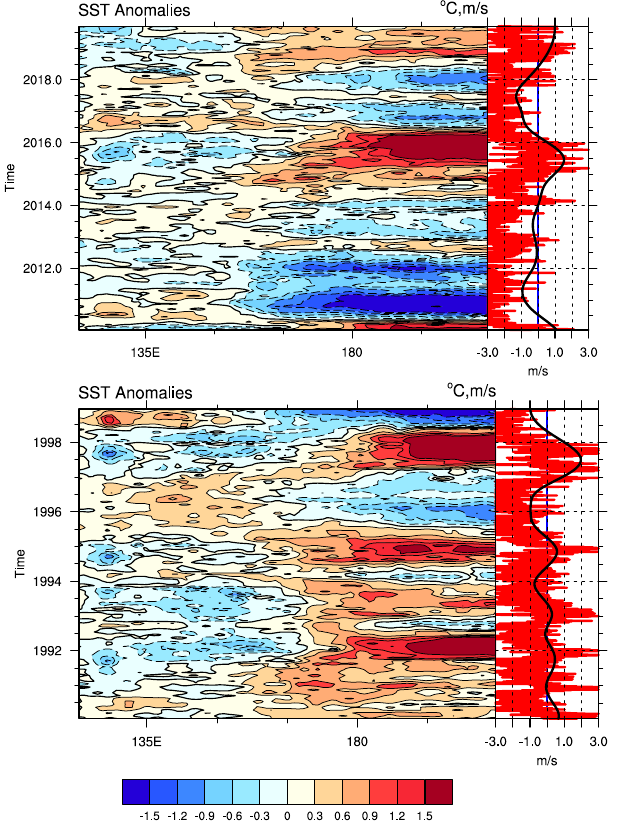
Figure 2. Time-longitude contour plots of the monthly sea surface temperature averaged for 2°S–2°N (left panel; in °C) interpolated to daily data over two decades covered two extreme ENSO events. The top panel is the 2015/16 case, and the bottom panel is the 1997/98 case. The solid red contours are the positive SSTa. The right panels are the same as Fig. 1 but use the traditional method of area averaging over the region 5°S-5°N, 135°E- 180°, shown in red curves, and IMFs 9–10 from EEMD are the same as those in the Fig. 1 and shown in black curves (units: m/s). Note that the red curve peaks follow each eastward shift in the red shading of the SSTa in the right panel. Maps were generated using the NCAR Command Language (NCL; https ://www.ncl.ucar.edu/), version